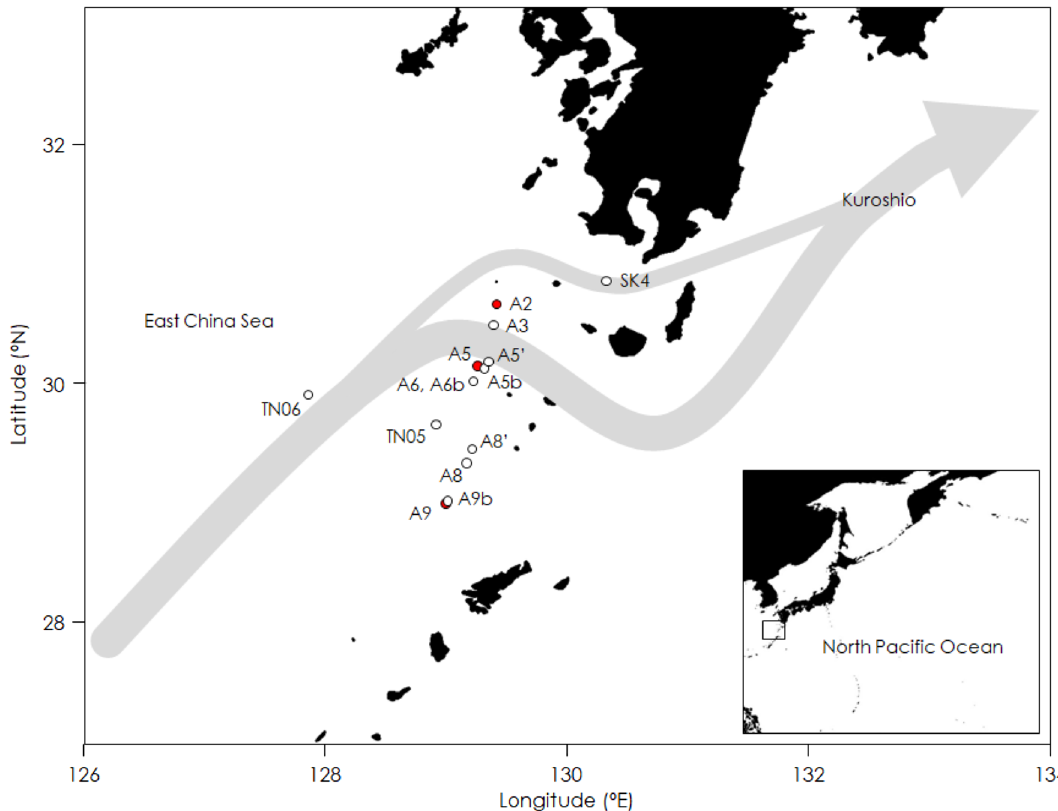
Figure 1. Sampling locations for water samples (solid red circles) and mesozooplankton (solid red and open circles) for metabarcoding analysis in the Kuroshio of the East China Sea and its neighboring waters. Arrows show current